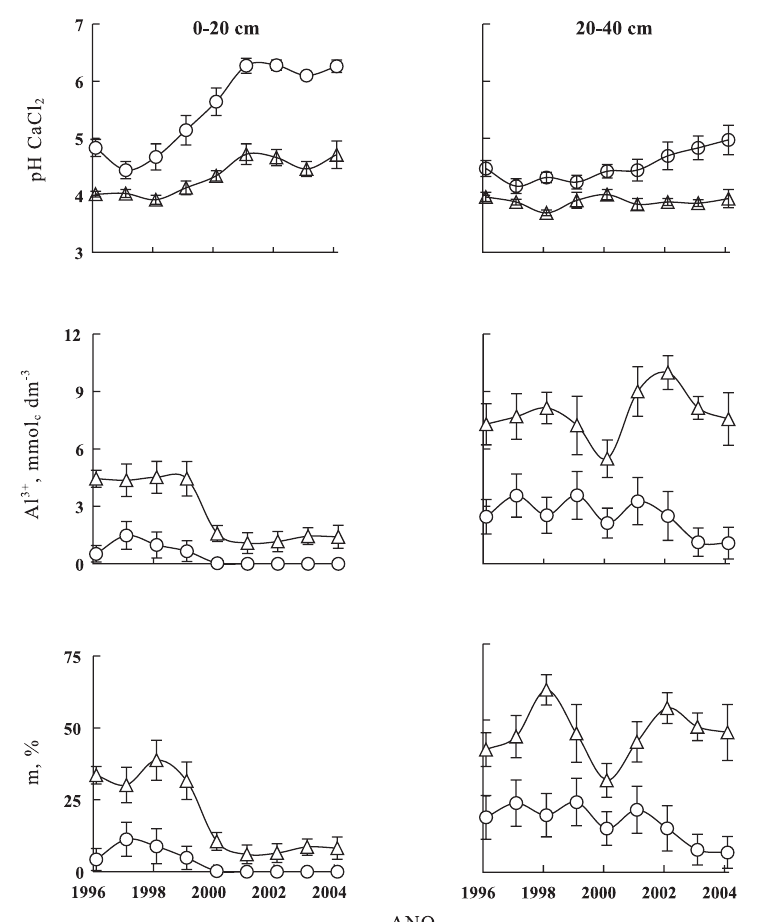
Figura 1. Valores médios e intervalos de confiança da média (p < 0,05) pelo teste t (barras verticais) do pH- CaCl , Al 3+ e saturação por Al 3+ (m), antes das calagens superficiais (1996) e após as calagens 2 superficiais (1997-1999), nas faixas de adubação ( ) e no centro das entrelinhas ( ) a 0–20 e 20–40 cm de